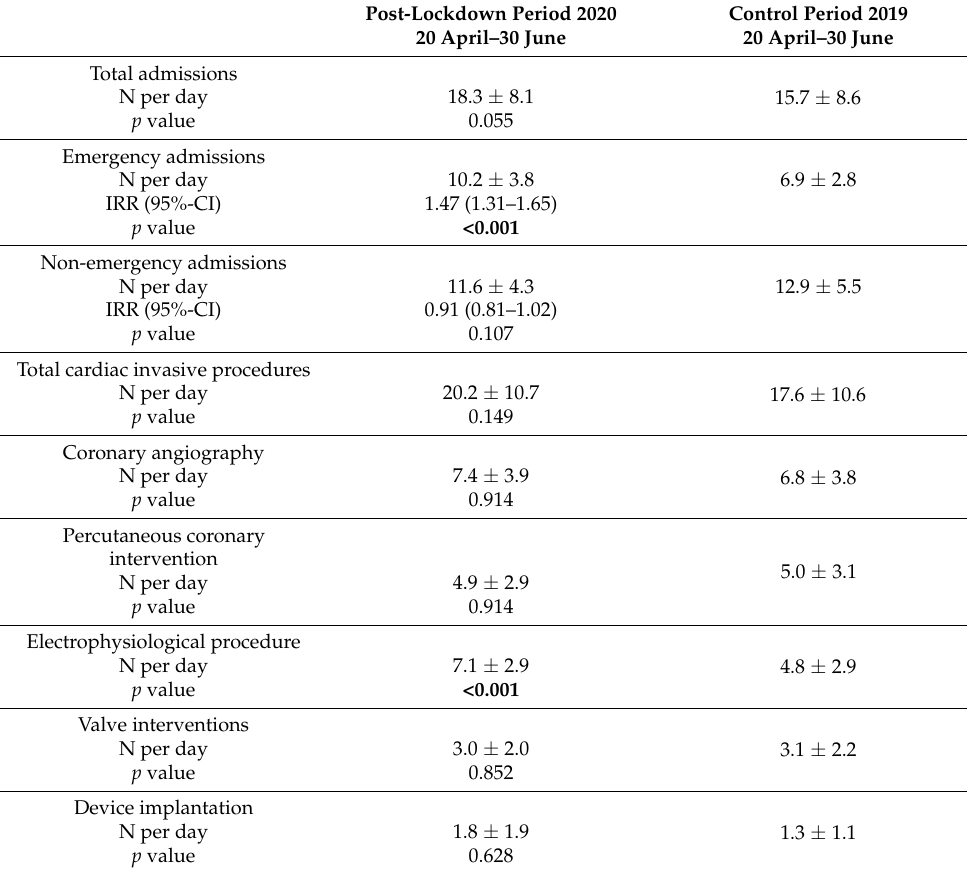
Table 3. Incidence rate ratios and daily numbers of hospital admissions and invasive cardiac procedures between the post-lockdown period 2020 and the corresponding period 2019 (20 April–30